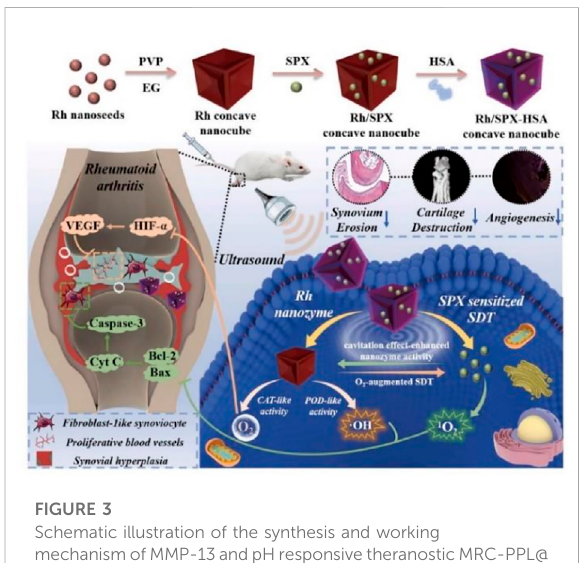
FIGURE 3 Schematic illustration of the synthesis and working mechanism ofMMP-13andpHresponsivetheranosticMRC-PPL@ PSO nano-micelles for OA (Li et al., 2021). Copyright, 2021,